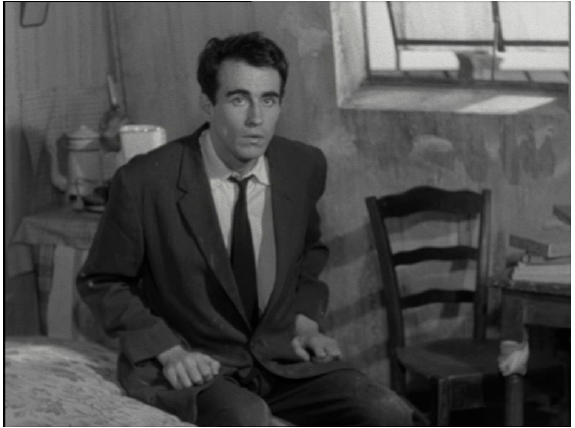
Figure 4. Michel in his dreary abode. Source Artificial Eye: ART 295 DVD.